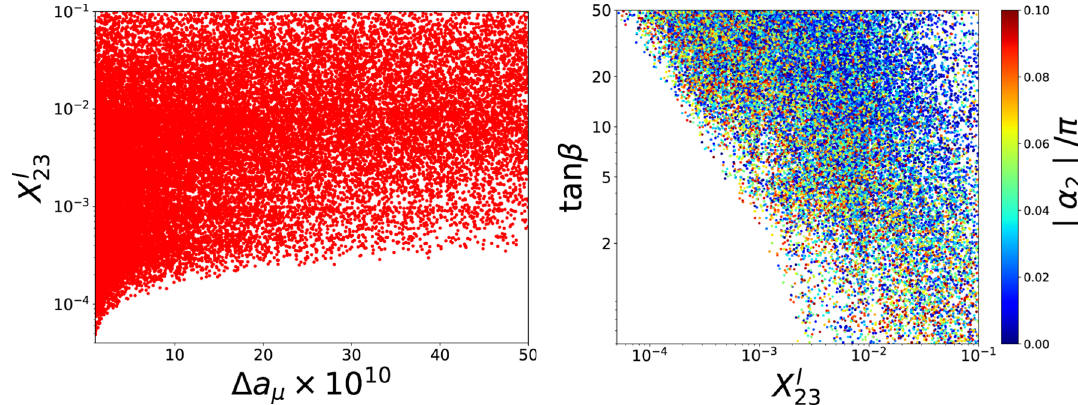
Figure 8 . The allowed parameter regions satisfying the muon g − 2 value within 1 × 10 − 10 < ∆ a µ < 50 × 10 − 10 , for X l = − X l 32 23